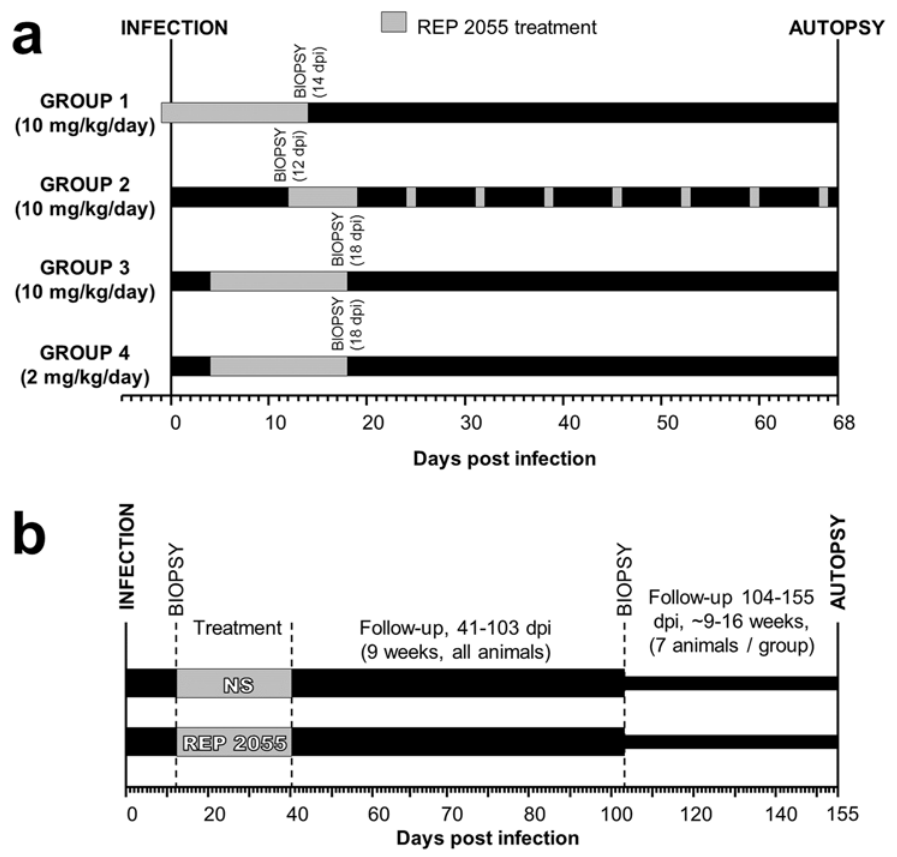
Fig 1. Experimental design of REP 2055 and NS treatment in in vivo Experiment 1 and 2. Fourteen-day- old ducks were infected with 5x10 8 DHBV genome equivalents via the jugular vein. In Experiment 1 (a) all ducks were treated by IP injection with REP 2055. Group 1 received 10 mg/kg/day from 1 day prior to DHBV infection to 14 dpi; Group 2 received 10 mg/kg/day from 12 – 19 dpi and 10 mg/kg once weekly for 49 days; Group 3 received 10 mg/kg/day from 4 – 18 dpi and; Group 4 received 2 mg/kg/day from 4 – 18 dpi. After treatment, ducks in Groups 1, 3 and 4 were followed for an additional 49 days, from 19 – 68 dpi. Liver biopsies were performed prior to treatment in Group 2 and at the end of treatment in Groups 1, 3 and 4. Autopsies were performed at 68 dpi at the end of treatment in Group 2 and the end of follow-up in Groups 1, 3 and 4. In Experiment 2 (b), 14 DHBV-infected ducks were treated by IP injection with 10 mg/kg/day of REP 2055 from 12 – 40 dpi. A control group of 14 DHBV-infected ducks received daily IP injections of NS. Blood samples were collected during treatment and from 41 – 103 dpi during the first 9 weeks of follow-up. Based on interim analysis of serum DHBV DNA, 7 REP 2055-treated ducks that maintained control of their infection and 7 randomly selected NS-treated ducks, were followed from 103 – 155 dpi (total 16 weeks of follow-up). Liver biopsies were performed in all animals at 12 dpi prior to treatment. Biopsies or autopsies were performed at 103 dpi (9 weeks follow-up) and additional autopsies were performed in 7 animals per group at 155 dpi (16 weeks